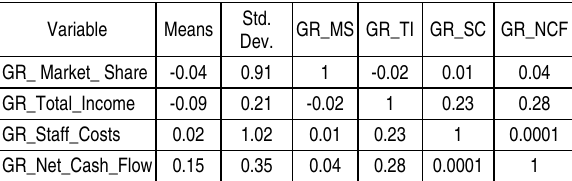
Table 1. Correlations between the criteria for banks’